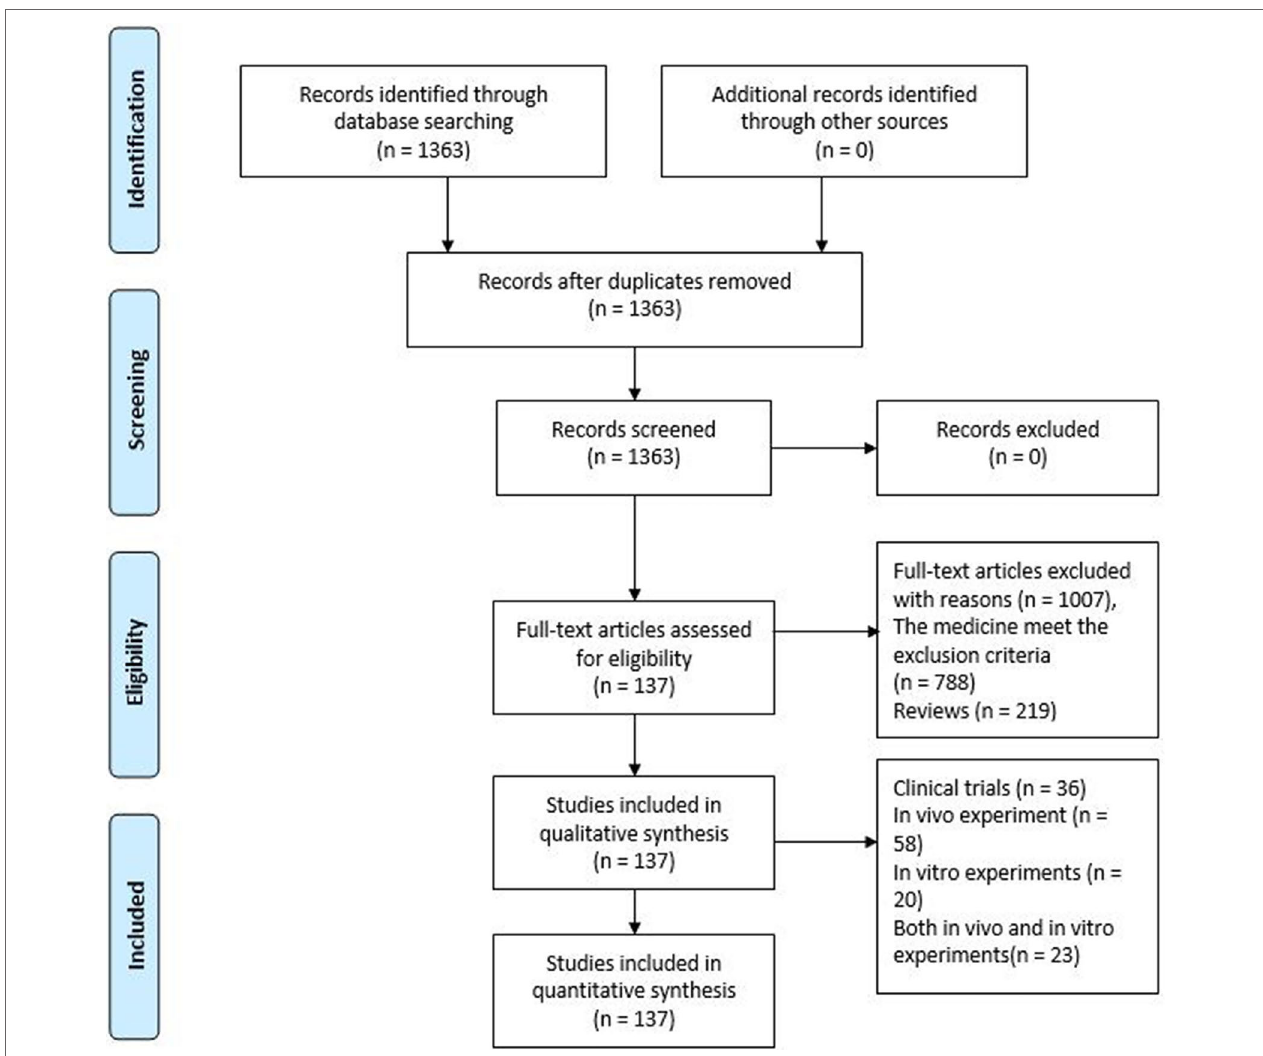
FIGURE 1 | PRISMA 2019 Flow